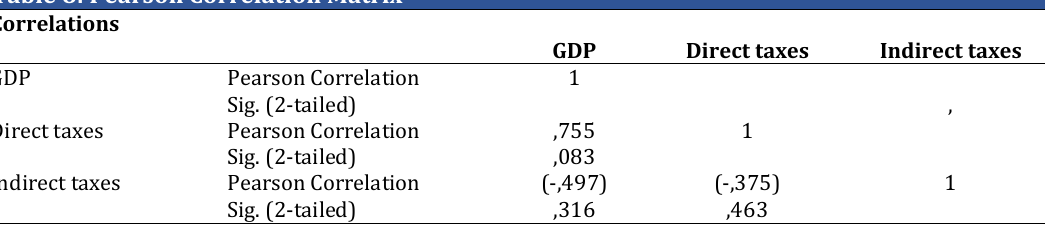
Table 8: Pearson Correlation Matrix